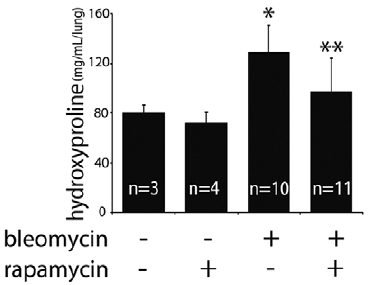
Figure 3. Effects of rapamycin on bleomycin induced fibrosis and autophagy. Hydroxyproline assay measuring lung collagen content demonstrates co-administration of rapamycin and bleomycin protects against fibrosis (*p = 0.003 for control vs. bleomycin;